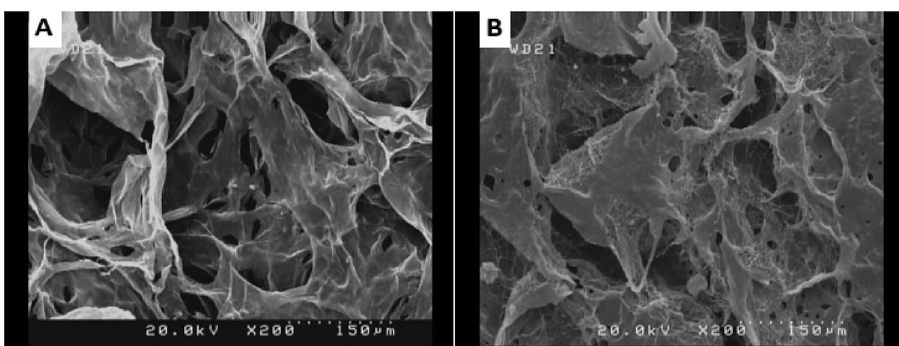
Figure 2. FESEM images of Col ( A ) and Col-rGO ( B ) scaffolds, depicting 3D porous